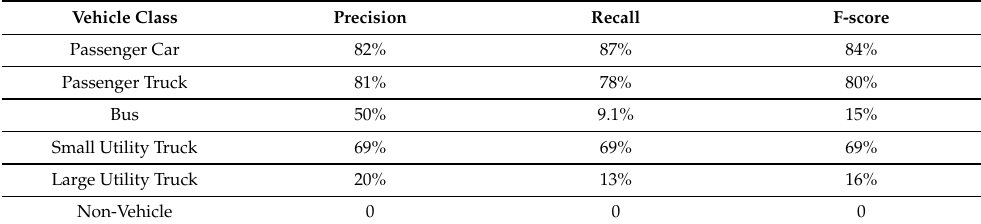
Table 21. Different evaluation metrics for detected vehicles in multiple vehicle clusters within Video